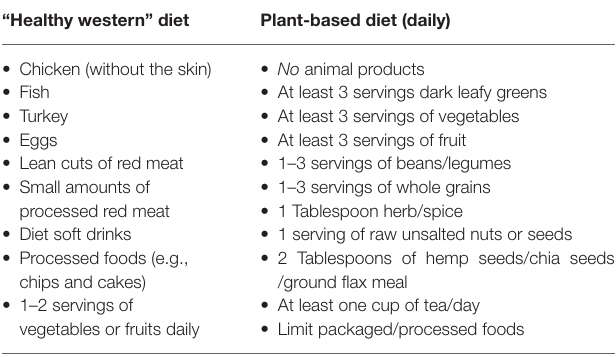
TABLE 1 | Patient’s dietary pattern pre- and post-dietary change. “Healthy western” diet Plant-based diet (daily)